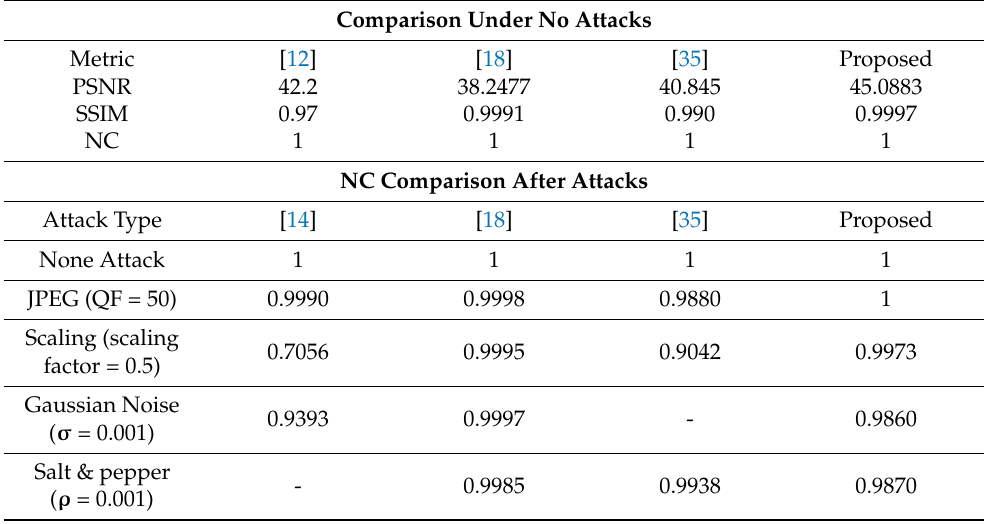
Table 7. Watermarking performance